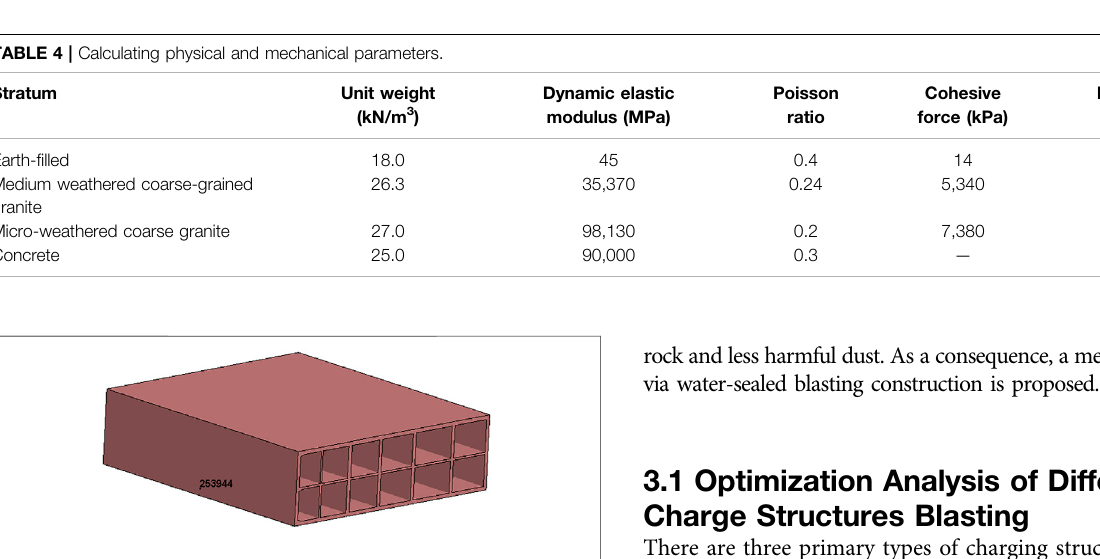
FIGURE 7 | Diagram of the location of the node (226,744).